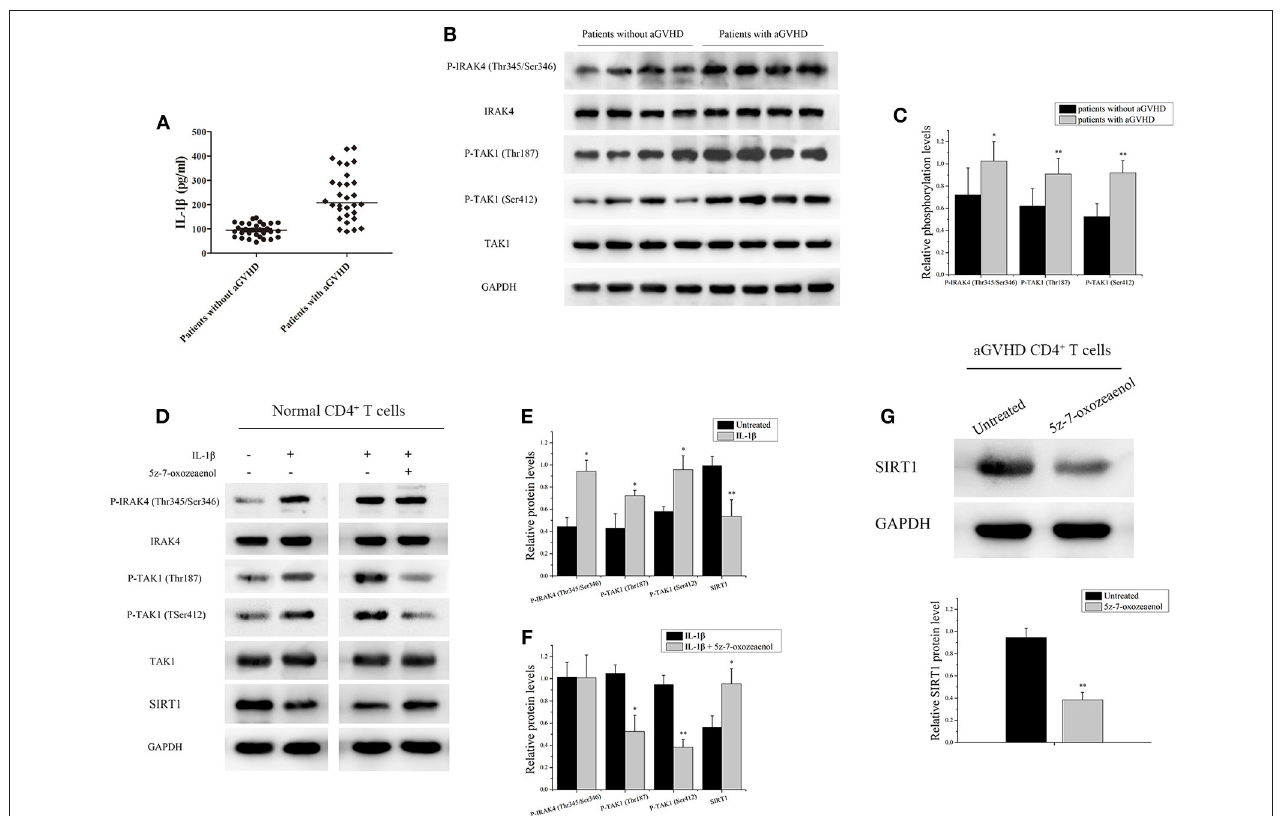
FIGURE 2 | IL-1 β signaling pathway downregulated the expression of SRIT1 in CD4 + T cells from patients with aGVHD. (A) The expression of IL-1 β was investigated in serum from patients with ( n = 30)/without ( n = 30) aGVHD using ELISA. (B) IRAK4 and TAK1 phosphorylation levels in CD4 + T cells from patients with aGVHD ( n = 10) and patients without aGVHD ( n = 10) were detected by Western blotting. (C) Quantitative analysis of the band intensities for IRAK4 and TAK1 phosphorylation levels normalized by total protein levels. (D–F) Representative western blotting results (D) and quantitative analysis (E,F) of the band intensities for IRAK4 and TAK1 phosphorylation levels in normal CD4 + T cells treated or not with IL-1 β /5z-7-oxozeaenol. (G) Representative western blotting results (top) and quantitative analysis (bottom) of the band intensities for SIRT1 protein level in CD4 + T cells from patients with aGVHD treated or not with 5z-7-oxozeaenol. Data are presented as the mean ± SD of the same experiments performed in three times. * p < 0.05, ** p <